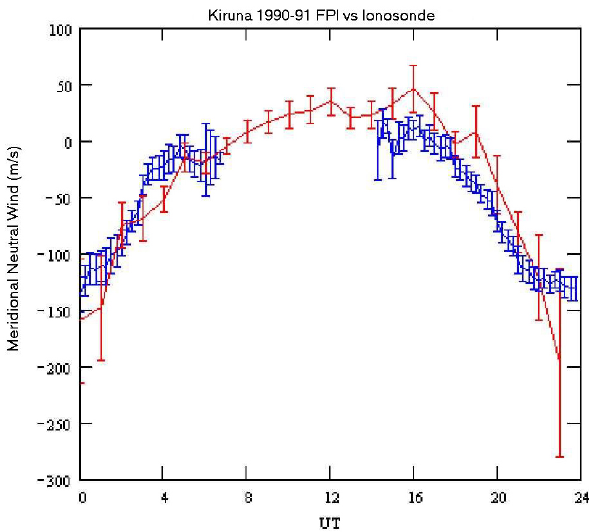
Fig. 2. A comparison of average meridional winds at solar max- imum from FPI measurements (blue line) at Kiruna compared to winds derived from Kiruna Digisonde measurements (red line).